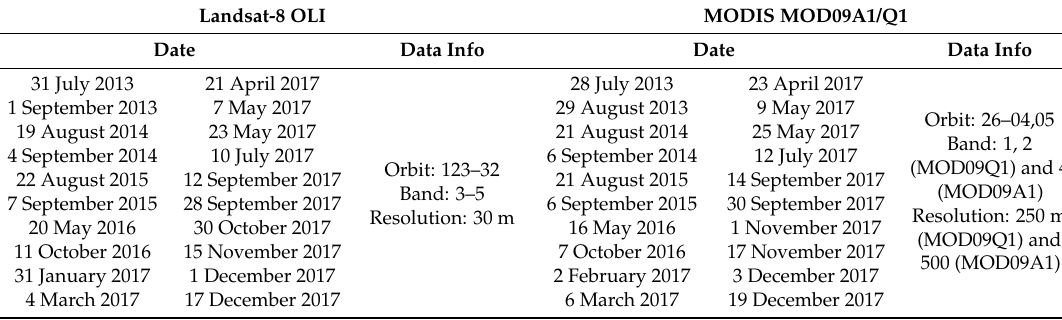
Table 1. Employed Landsat-8 OLI and MODIS reflectance products of the urban dataset.